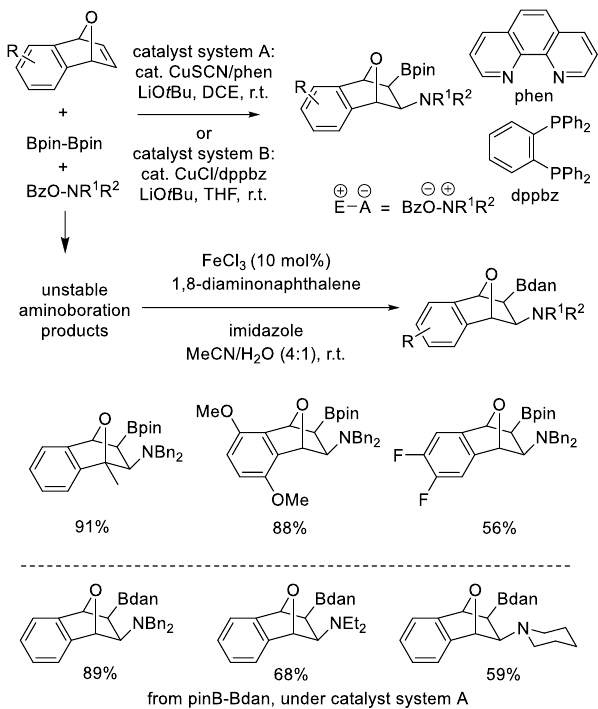
Scheme 17. Cu-catalyzed aminoboration of bicyclic alkenes.